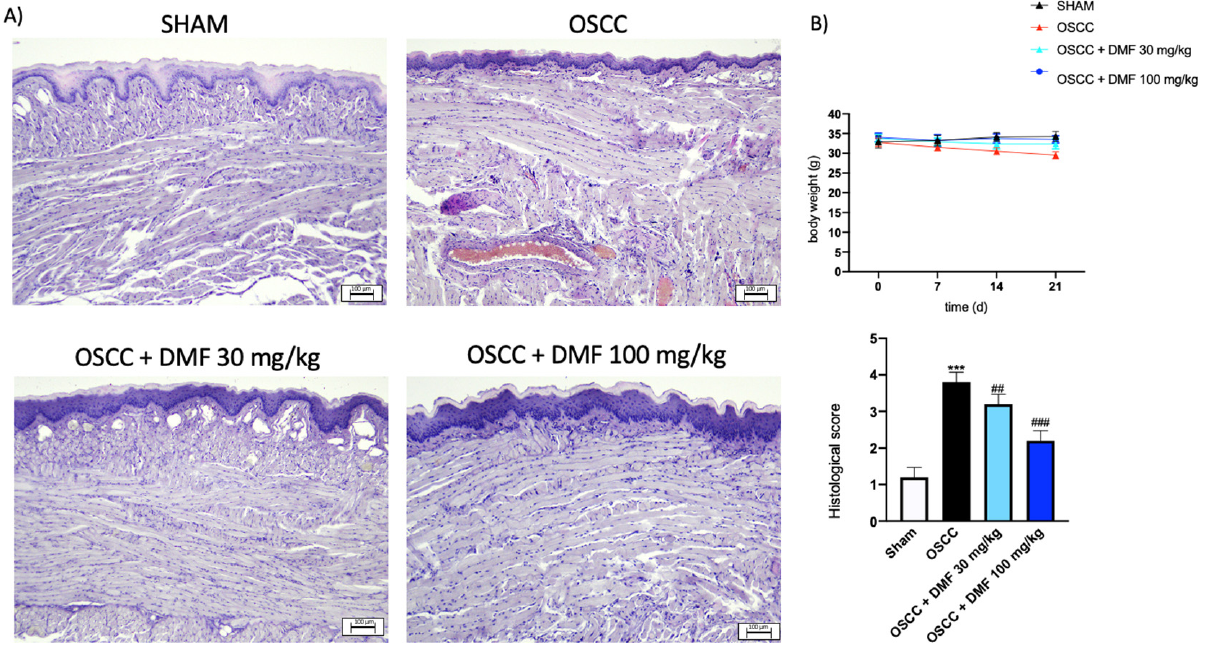
Figure 7. Effect of DMF on tumor growth in CAL27 orthotopic model. DMF treatment at doses of 30 and 100 mg/kg was able to significantly reduce submucosa tumor mass of the tongue and neutrophilic infiltration compared to control group ( A ). No important weight differences were detected between animals ( B ). Data are representative of at least three independent experiments. Sections were observed and photographed at 10× magnification. *** p < 0.001 vs. SHAM; ## p < 0.01 vs. OSCC; ### p < 0.001 vs. OSCC.